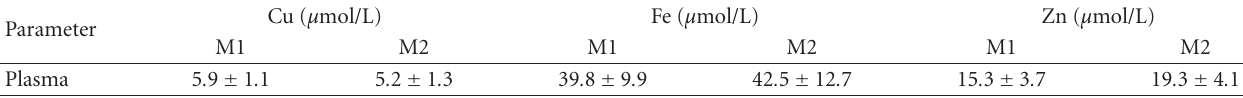
Table 1: Mean ± standard deviation of plasma concentrations of Cu, Zn, and Fe at the two visits on the farm. Cu ( µ mol/L) Fe ( µ mol/L) Zn ( µ mol/L) Parameter M1 M2 M1 M2 M1 Plasma